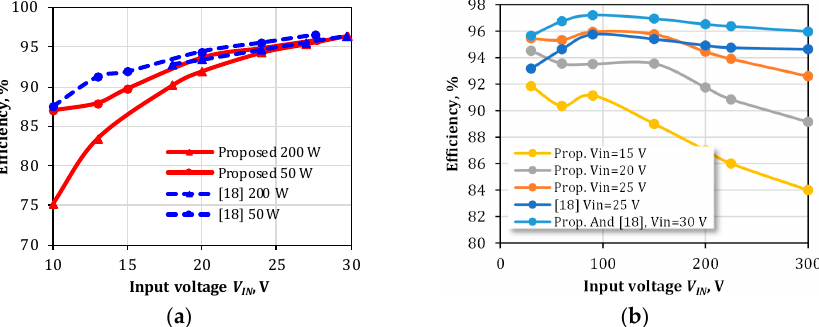
Figure 12. Comparison of the measured efficiency of the proposed and the baseline converters versus ( a ) the input voltage at two power levels and ( b ) the input power at different input voltage levels.